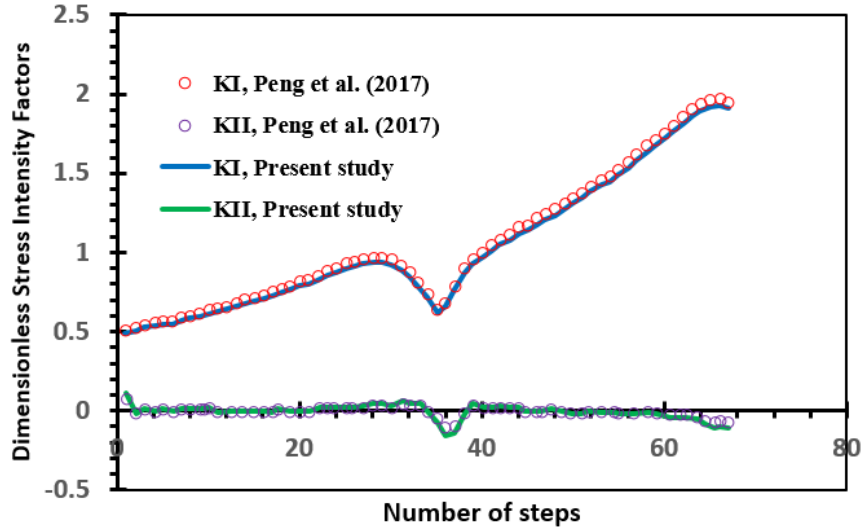
Figure 5. Comparison for the dimensionless stress intensity factors for specimen 1.